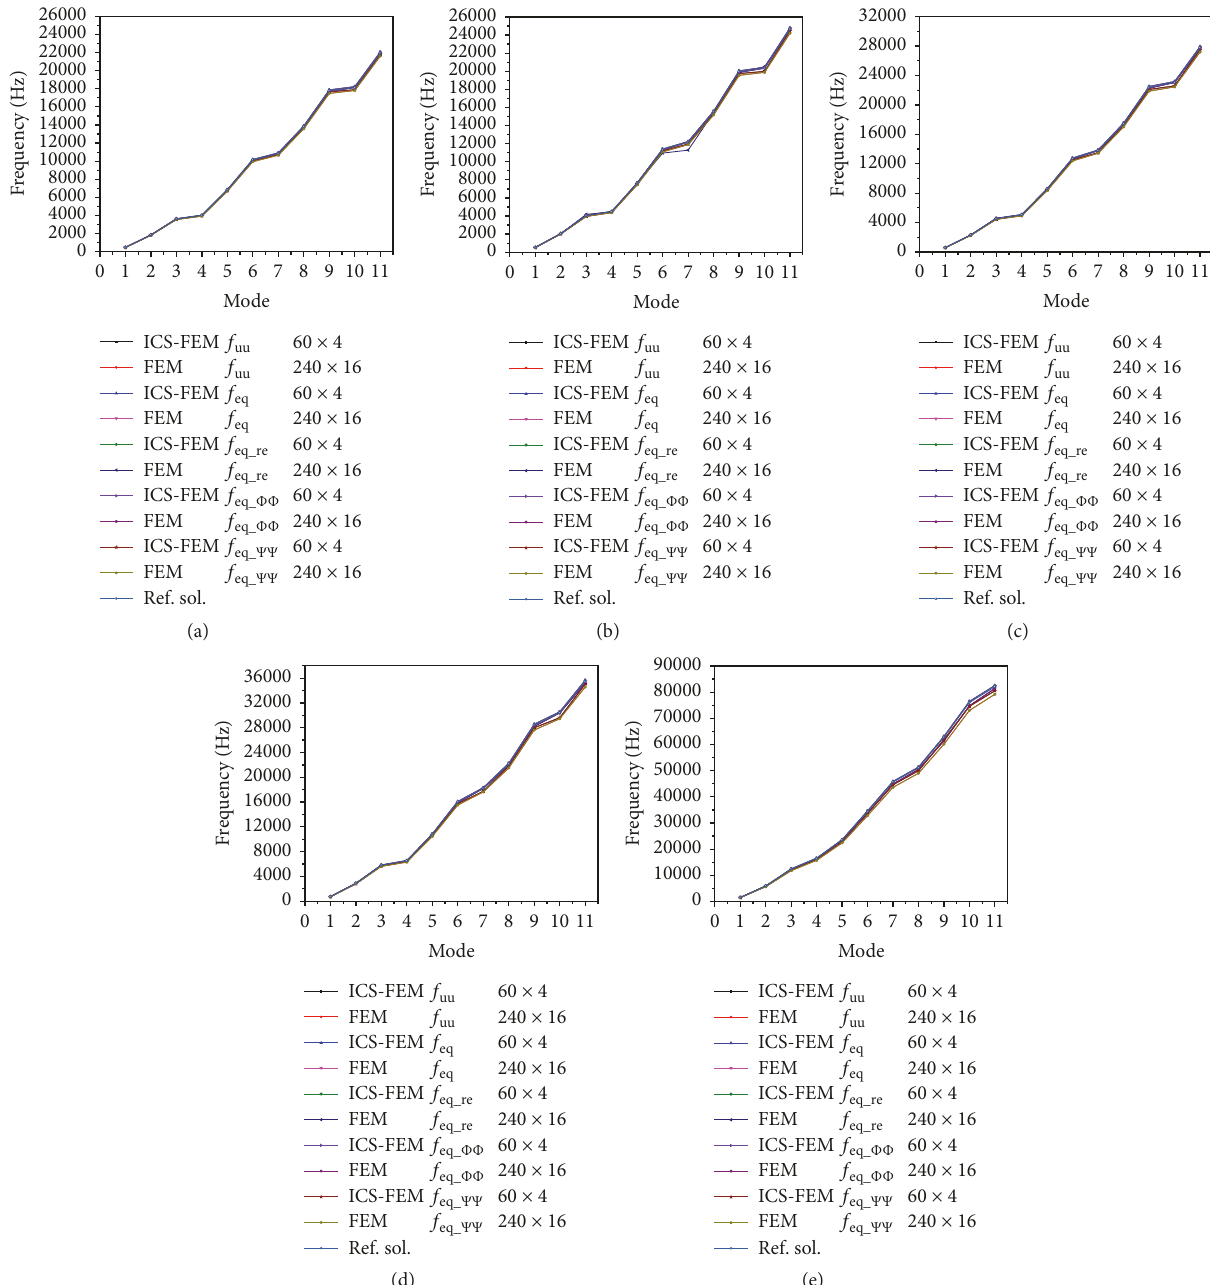
Figure 11: Structural frequencies 𝑓 for simply supported BaTiO 3 -CoFe 2 O 4 FGMEE beams with exponential factor 𝜂 = (a) 0, (b) 0.5, (c) 1.0, (d) 2.0, and (e)